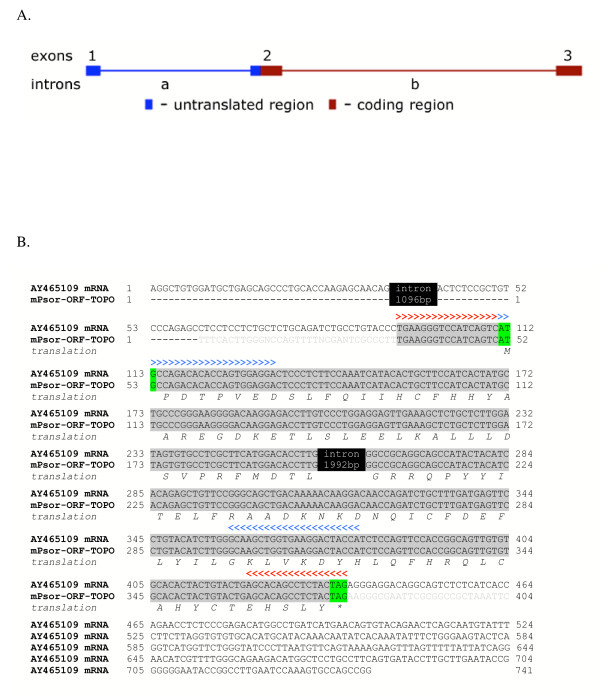
Cloned mouse S100A7/psoriasin sequence, and gene structure A The mouse S100A7 gene sequence (GenBank acc. AY465110) describes a 3829 bp gene with 3 exons and 2 introns. B The sequence of our mPsor-ORF-TOPO clone isolated by RT-PCR of RNA from a DMBA mouse mammary tumor is shown compared with the mouse S100A15 cDNA sequence (GenBank acc. AY465109) isolated from mouse skin. Predicted introns are inserted into the cDNA sequences (black), the predicted open reading frame (ORF) and translated products (amino acid one letter code in italics below the nucleotide sequence) are shown with start and stop codons (green). Vector sequences of the mPsor-ORF-TOPO are indicated in light grey. Sense (>) and antisense (<) primer annealing sites are indicated for both primer sets: mouse psoriasin (blue) and mouse psoriasin-ORF (red).